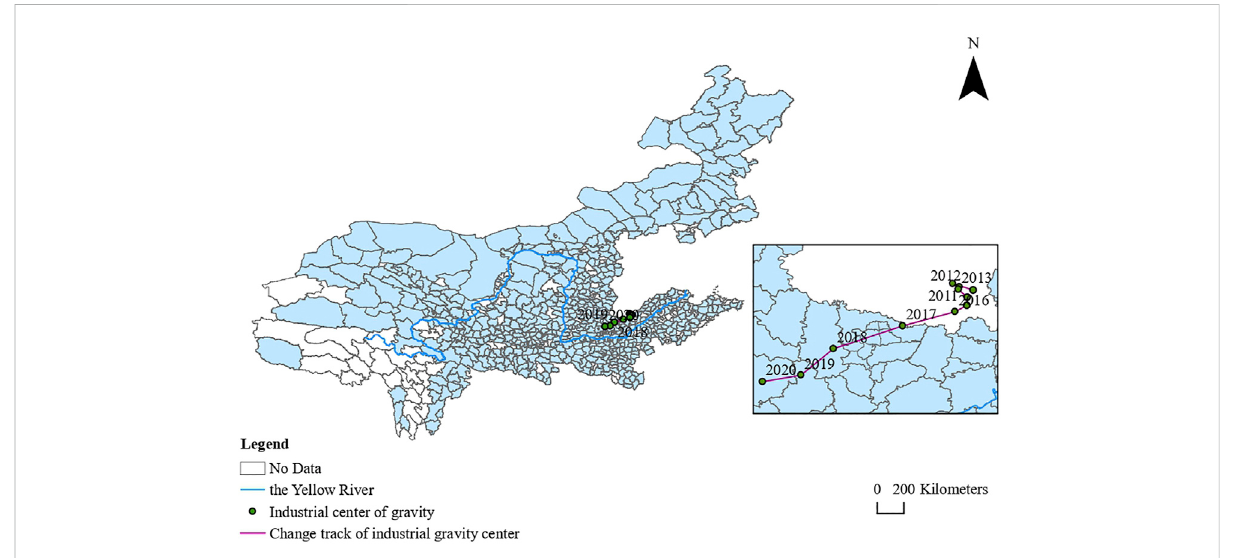
FIGURE 1 Changes in the industrial economic center of the YRB from 2010 to